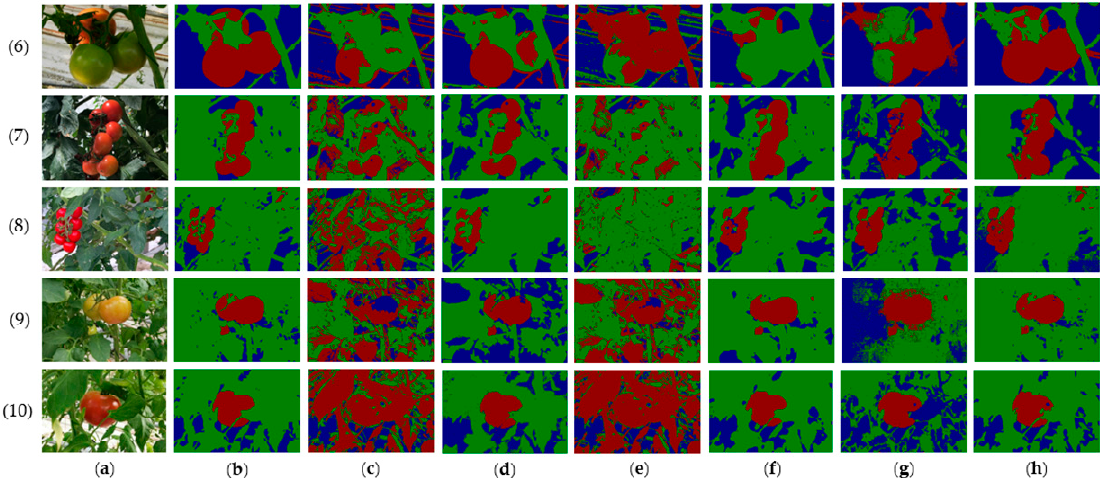
Figure 18. The result of different algorithms with close shots. Column ( a ) are original images. Column ( b ) are high quality ground-truth. Columns ( c – h ) are the results of several segmentation methods: quantum-behaved particle swarm optimization (QPSO), fuzzy c-means clustering (FCM), pulse coupled neural network-based segmentation (PCNN), co-segmentation, the traditional latent Dirichlet allocation (LDA), and self-adaptive latent Dirichlet allocation (SA-LDA), respectively.